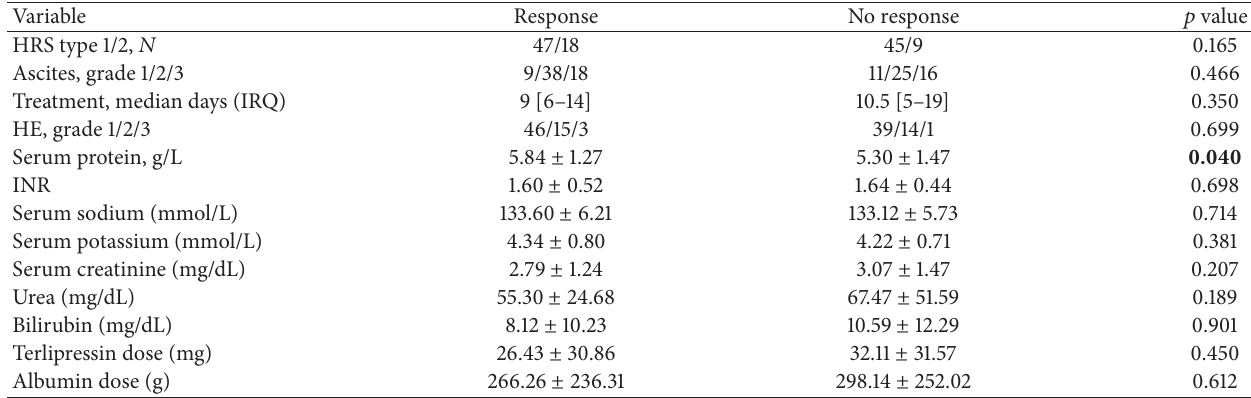
Table 2: Univariate analysis of the patient